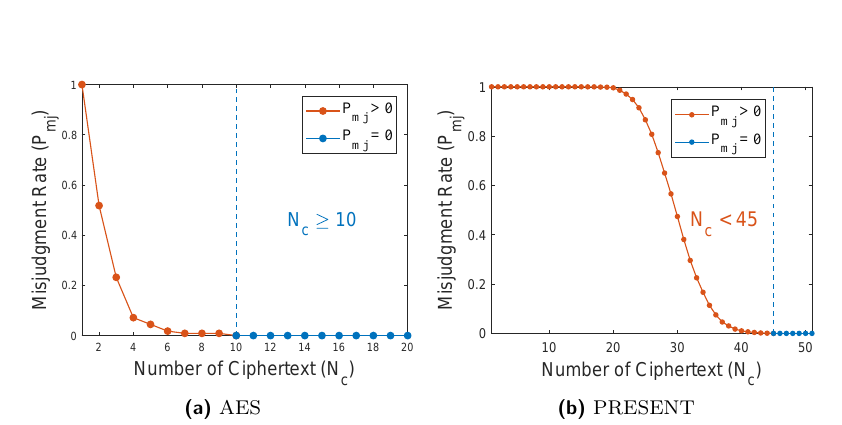
Figure 11: The misjudgment rate P mj v.s. the number of ciphertexts. No misjudgment will be made with 10 and 45 ciphertexts for AES and PRESENT,